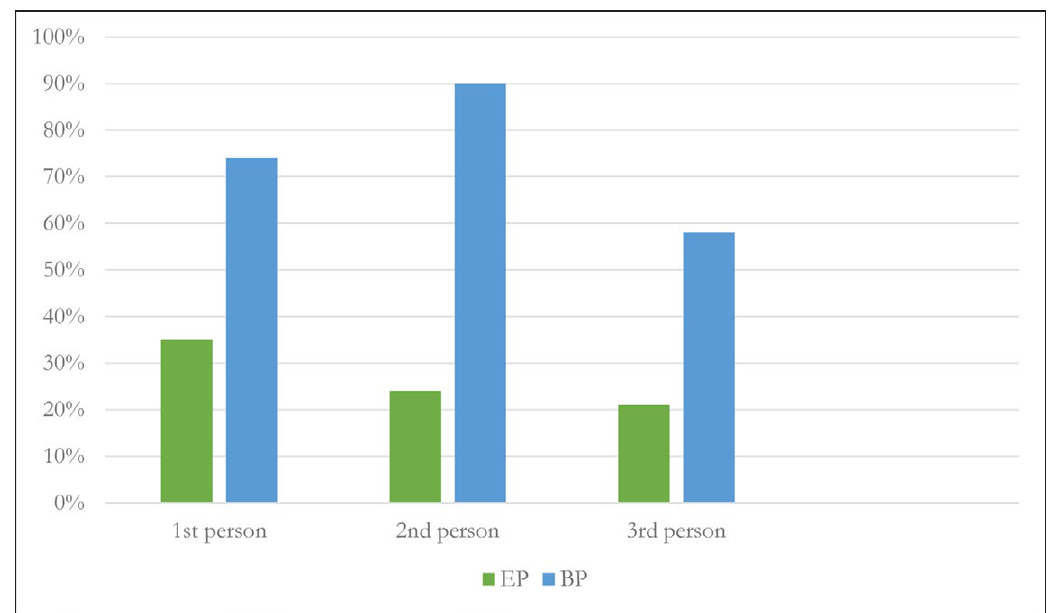
Figure 2: Overt subjects in spoken EP and BP. (Barbosa, Duarte & Kato 2005: 22; adapted from Duarte 2000: 25). Table 3: Frequency number of SPP in Angolan Portuguese (369 sentences).